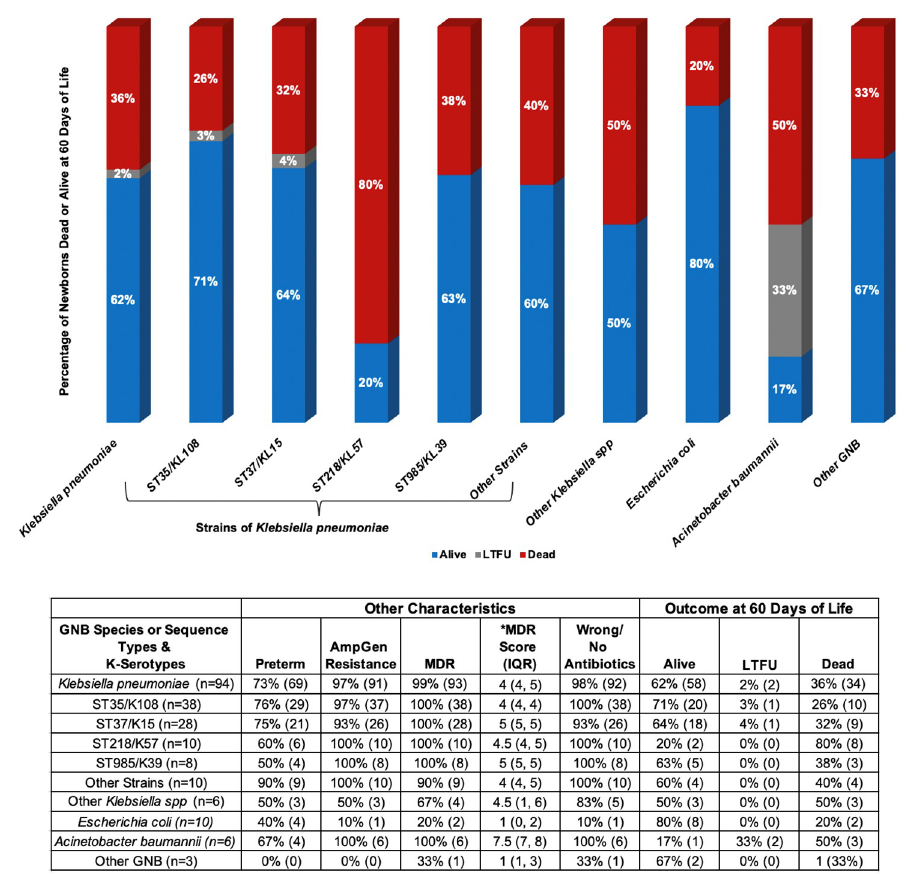
Fig 12. Newborn mortality at 60 days by gram-negative species and strain. The ST218 Klebsiella pneumoniae strain was the most virulent strain; 80% of newborns infected with ST218 died. GNB: gram-negative bacteria; MDR: multidrug resistance; MDR Score: number of antibiotic classes where an organism/strain is resistant to at least one antibiotic agent; LTFU: lost to follow-up.